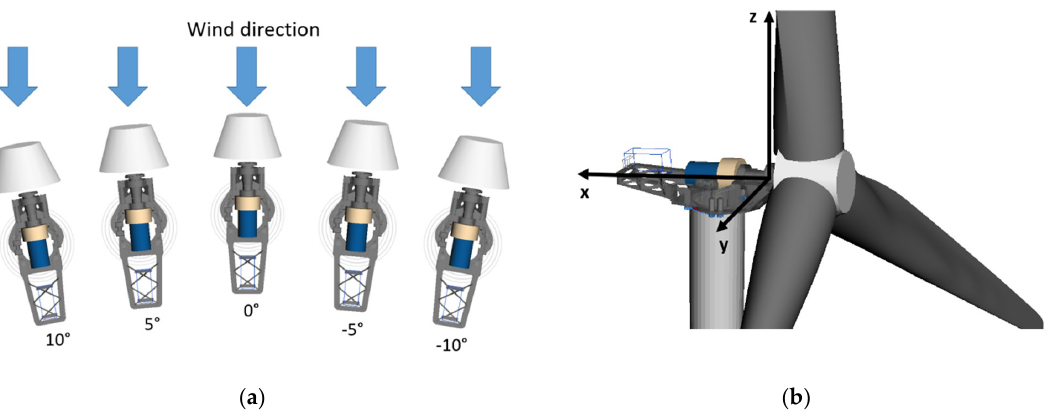
Figure 1. ( a ) Nacelle positions relative to wind direction as seen from above; ( b ) multi body simulation model of the C3 × 126 with coordinate system [15].